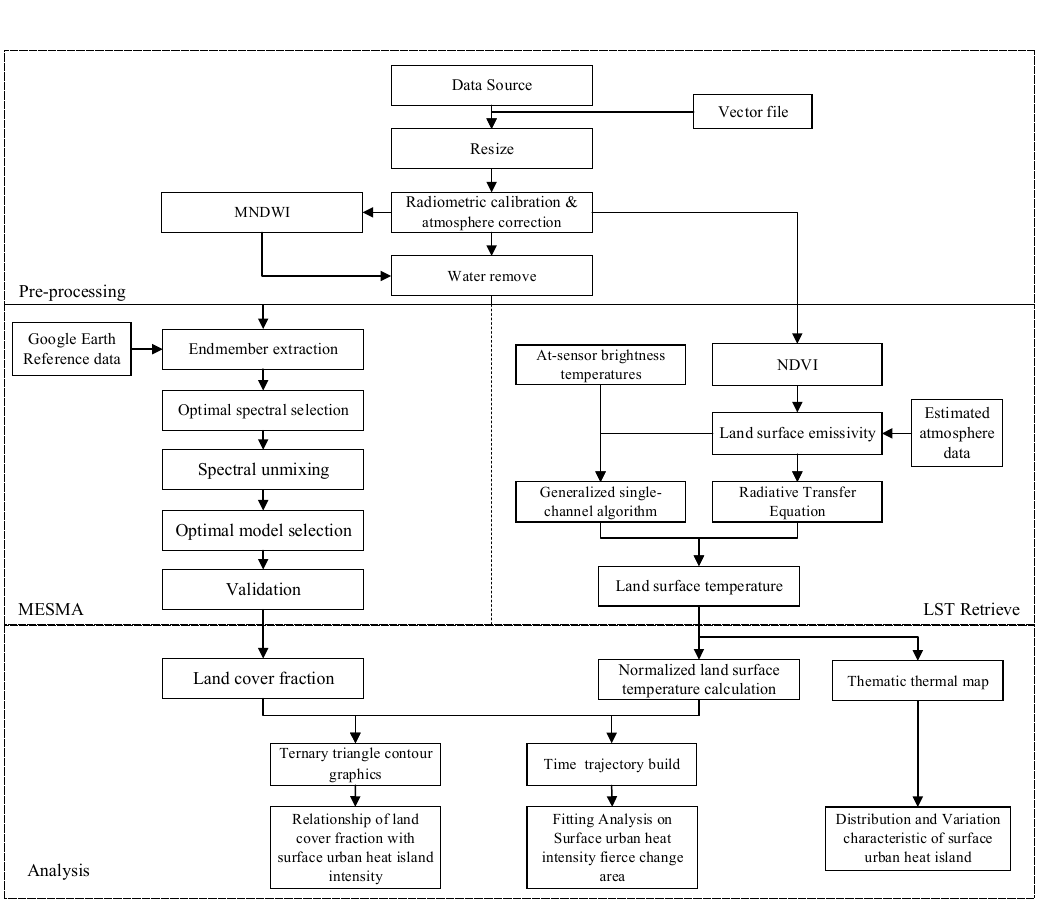
Figure 2 . Flow chart for this study. Figure 2. Flow chart for this